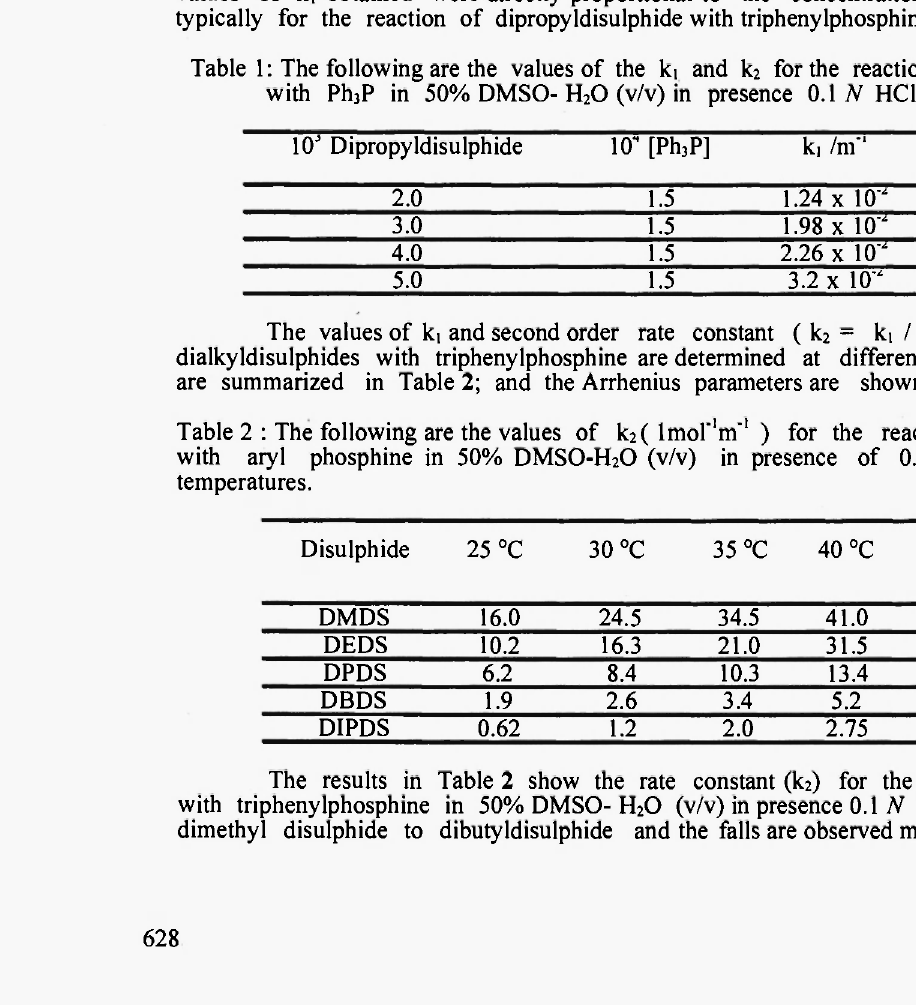
Table 1: The following are the values of the ki and k 2 for the reaction of dipropyl disulphide with Ph